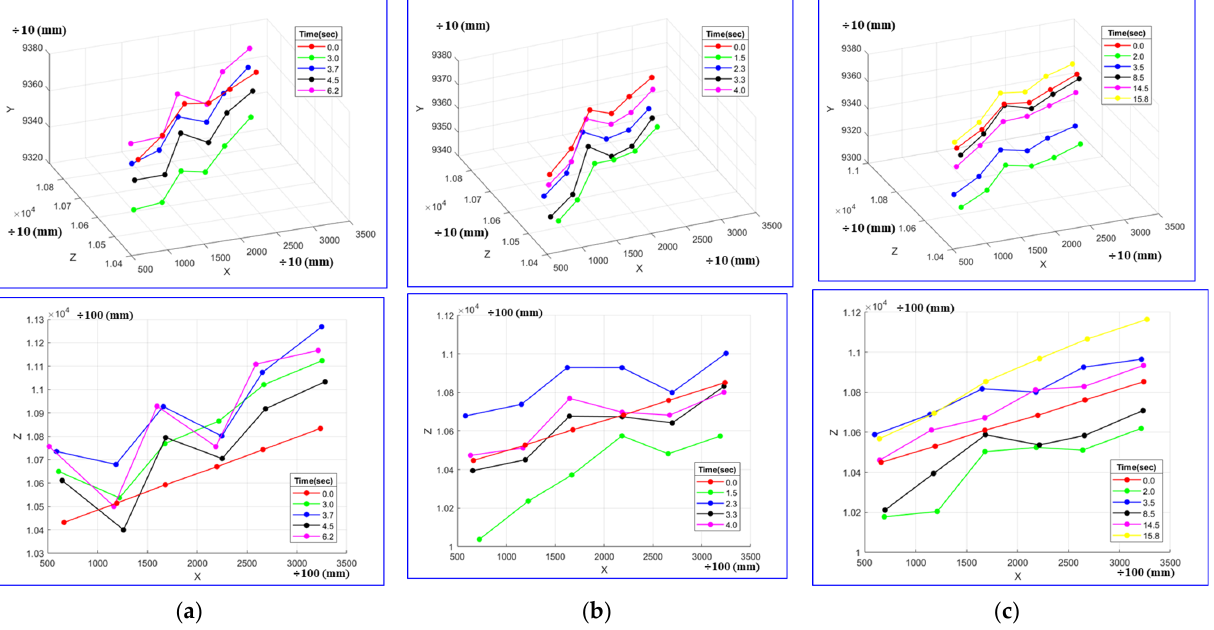
Figure 10. Consecutive deformation patterns during the loading of the train measured by the proposed method. The 3D space ( top ) and X ‐ Z plane ( bottom ) displacements are magnified by 10 and 100 times, respectively, and color represents time. ( a ) First train; ( b ) second train; ( c ) third train.